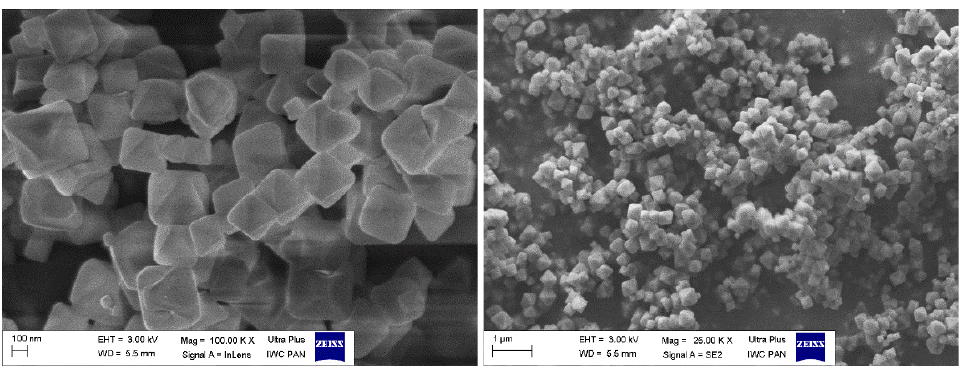
Figure 1. SEM images of synthesised sorbent.